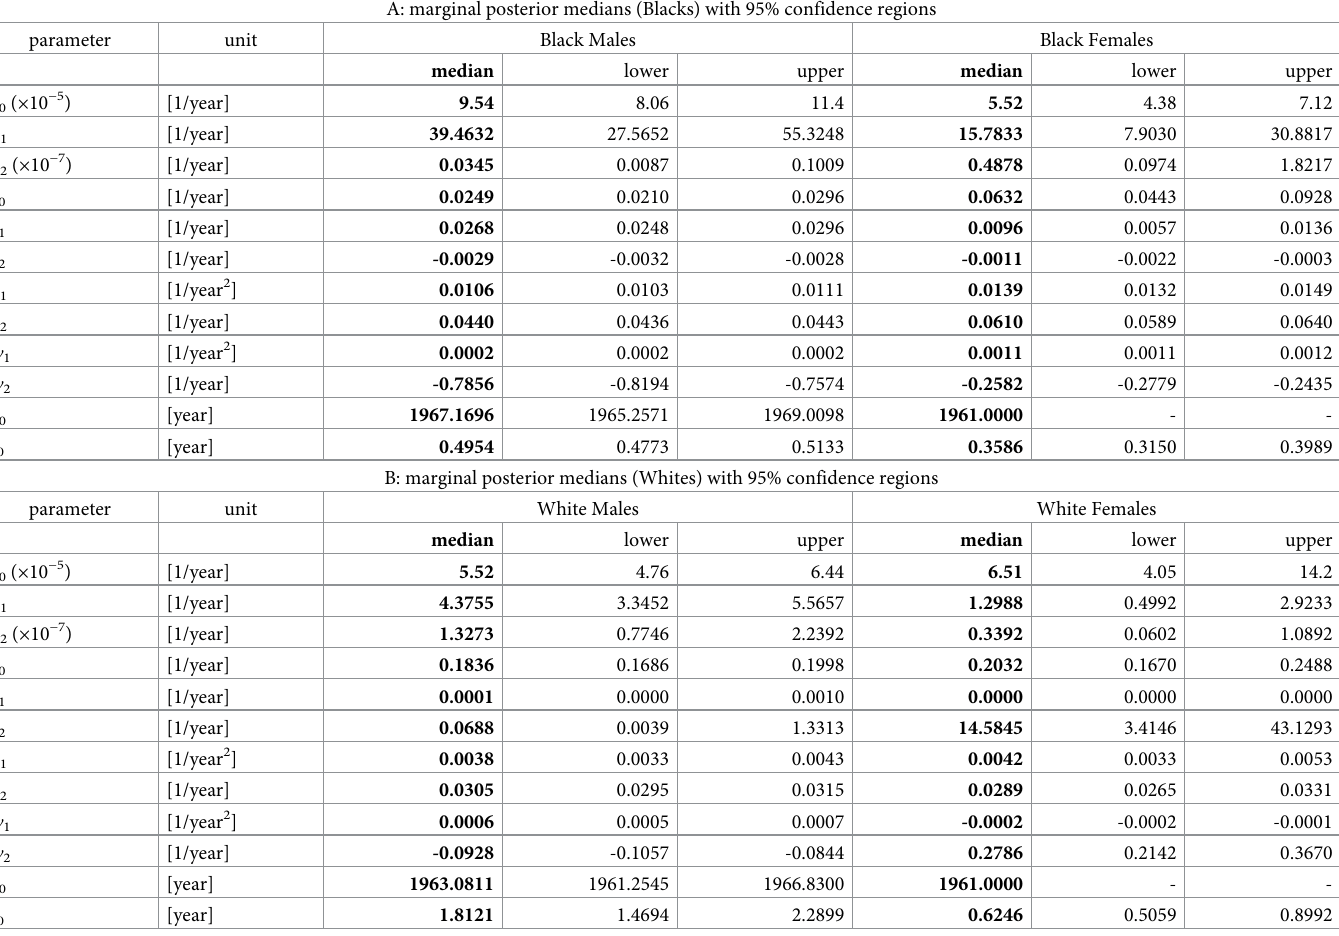
Table 1. Parameter estimates are based on posterior samples obtained via Markov Chain Monte Carlo (MCMC) using random uniform prior distributions with boundaries that were well outside the obtained 95% confidence regions. For sampling, we used a multivariate Metropolis-Hastings algorithm with > 100, 000 samples for Males and > 200, 000 samples for Females. The marginal medians listed in this table agreed well with the obtained maximum likelihood estimates and led to very similar incidence predictions (S3 Fig). A: marginal posterior medians (Blacks) with 95% confidence regions